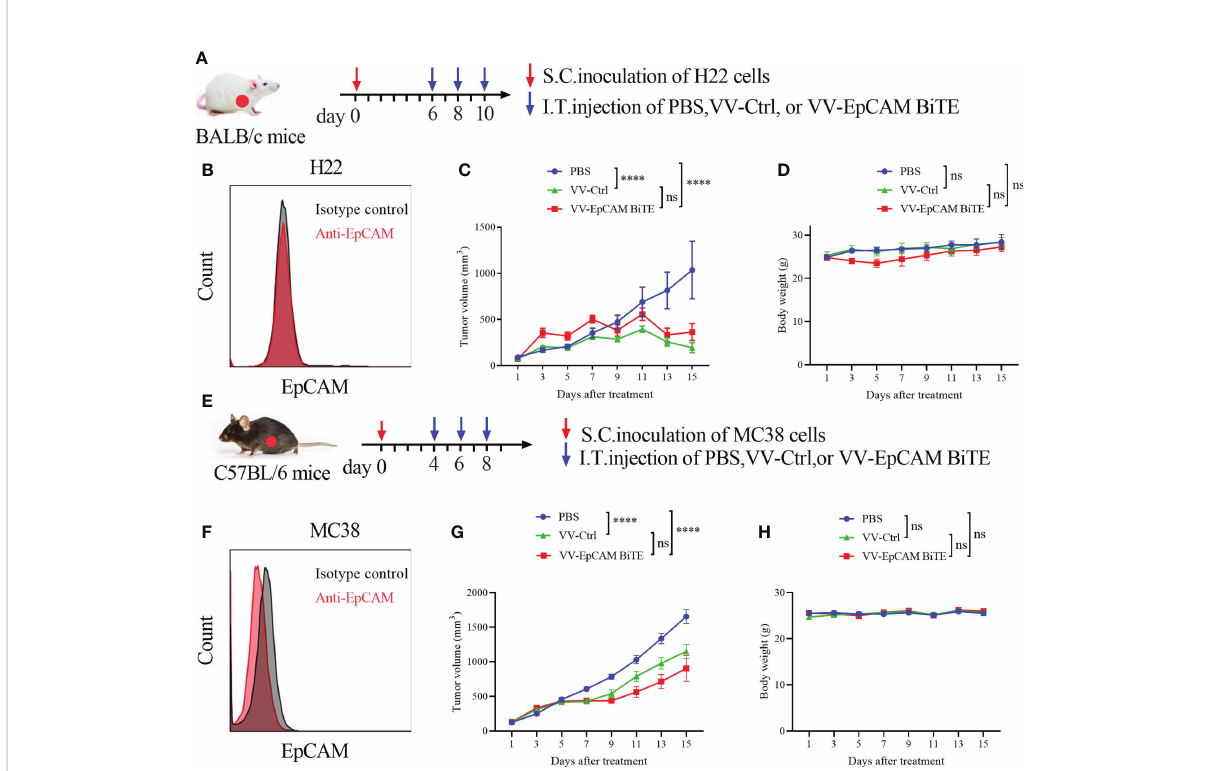
FIGURE 5 Antitumor effect of VV-EpCAM BiTE in the EpCAM-negative tumor model. (A) Experimental timeline for H22 models. BALB/c mice were subcutaneously inoculated with 2x10 6 H22 cells. When the tumor size reached 100 mm 3 (Day 6), VV-Ctrl, VV-EpCAM BiTE (1 × 10 7 pfu) or PBS was injected intratumorally into the mice, and this was repeated on Days 8 and 10. (B) Flow cytometry analysis of EpCAM expression on the surface of H22 cells. (C) The volumes were monitored by caliper measurement once every other day. Data are presented as means±SEM. (D) Body weight of H22-bearing mice. (E) Experimental timeline for MC38 models. C57BL/6J mice were subcutaneously inoculated with 2x10 6 MC38 cells. When the tumor volume was approximately 100 mm 3 , randomized groups were treated with VVs (1 × 10 7 pfu) or PBS. (F) Flow cytometry analysis of EpCAM expression on the surface of MC38 cells. (G) Caliper measurements were made on the MC38 tumors. (H) Body weight of MC38-bearing mice. ns, no signi fi cant differences; ****p <